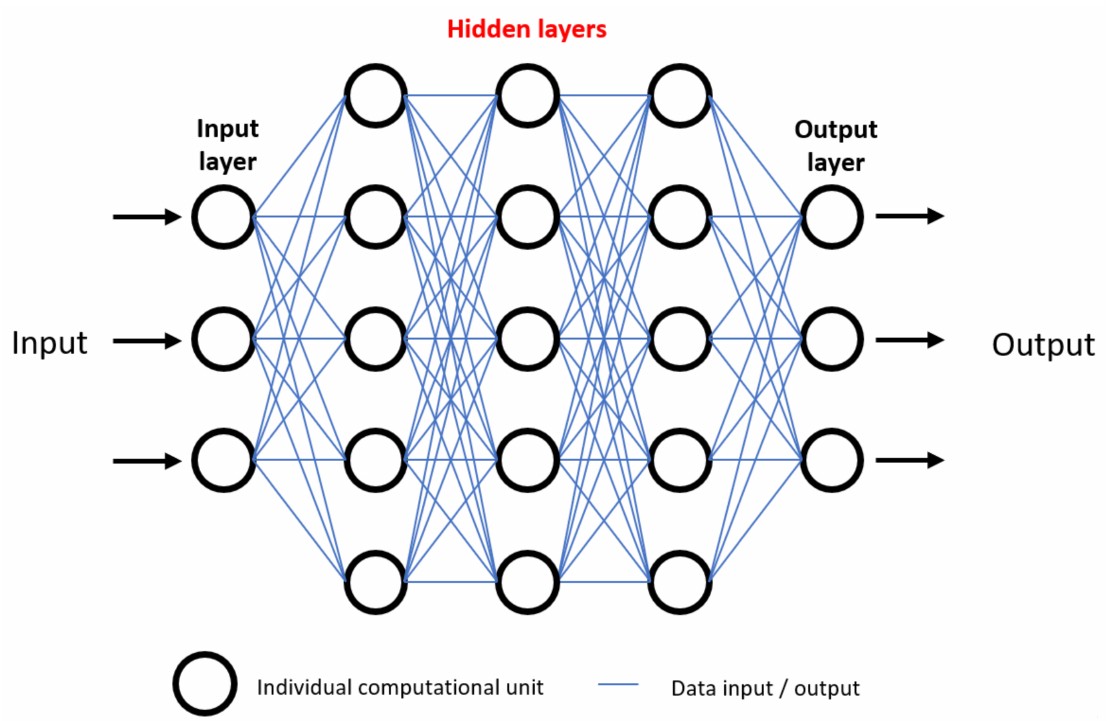
Figure 3. Visual representation of an artificial neural network, demonstrating the “black box” ethical problem. Numerous data inputs are processed among many hidden layers of computational units, ultimately resulting in an output. For example, data inputs may be tumour grade, location, and patient demographics. After data processing, outputs may be survival prediction or response to certain therapeutics. Inability to understand how outputs are generated due to complexity of hidden layers is referred to as the black box problem, and raises concerns regarding trust in deep learning predictive models.